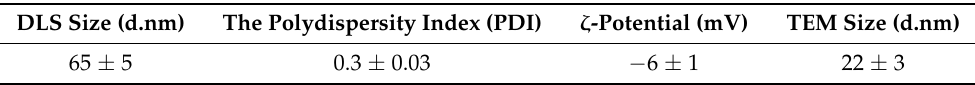
Table 1. Summarizes the hydrodynamic radius of the generated nanoparticles with their corresponding polydispersity index and the ζ -potential and particles size as obtained from the TEM images ( n = 3).